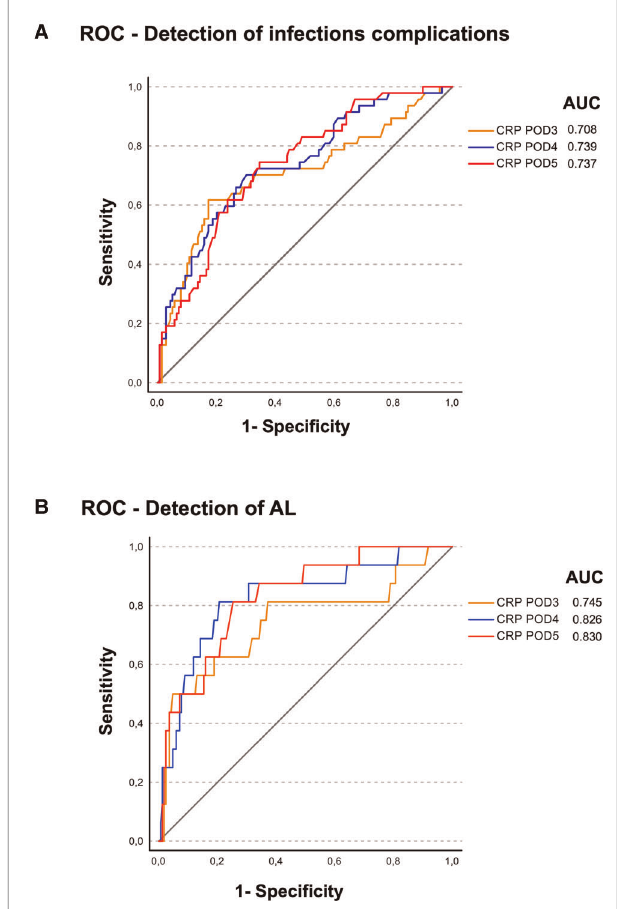
FIGURE 2 | ROC analysis was perfomed for the postoperative CRP levels from postoperative days (POD) 3, 4, and 5 for ( A ) diagnosis of infectious complications and ( B ) diagnosis of AL with the area under curve (AUC) given in the fi